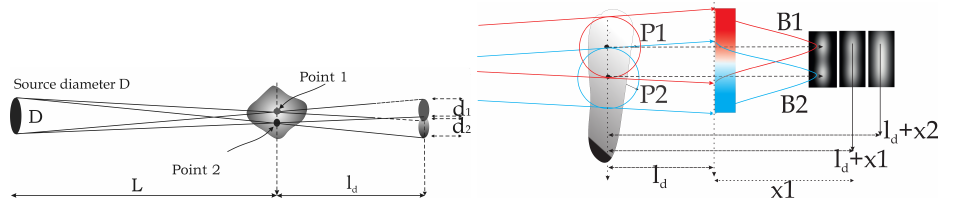
Figure 1. To distinguish two points in a sample, L, D, l d must be matched to each other. In the case of a crystal monochromator, D must be replaced by d mosaic , d moasic = mean grain size of the crystal monochromator and L/D then becomes L/d mosaic [41]. One